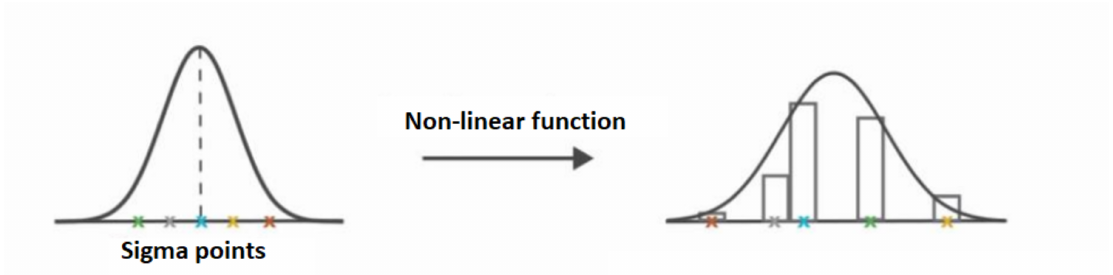
Figure 13. Probability distribution approximation using Unscented Kalman filter (UKF) with sigma points.